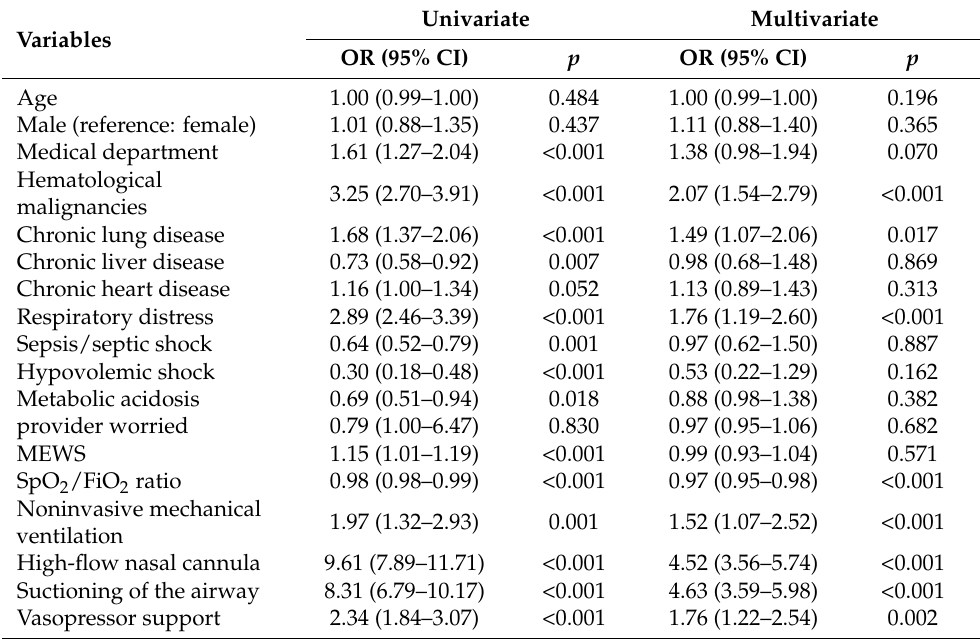
Table 4. Univariate and multivariate logistic regression analyses for repeat medical emergency eam activation.